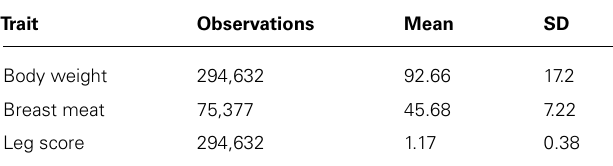
Table 2 | Number of observations, mean, and SD for the three traits.